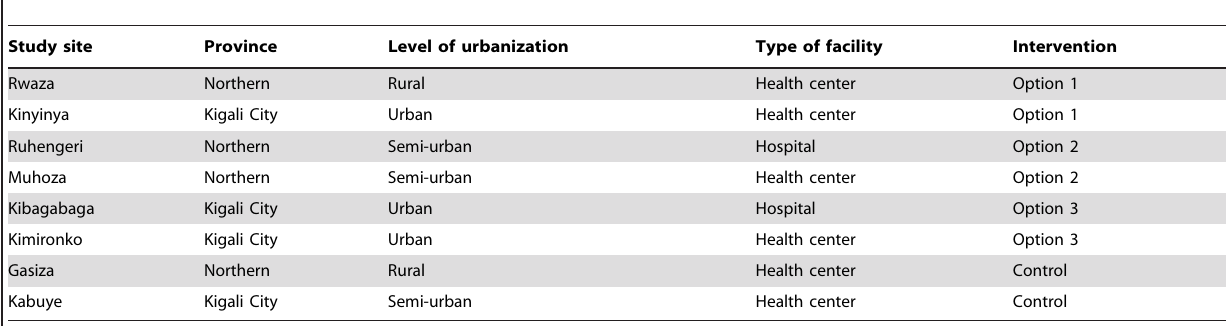
Table 1. Characteristics of intervention and control sites, PITC study, Rwanda,